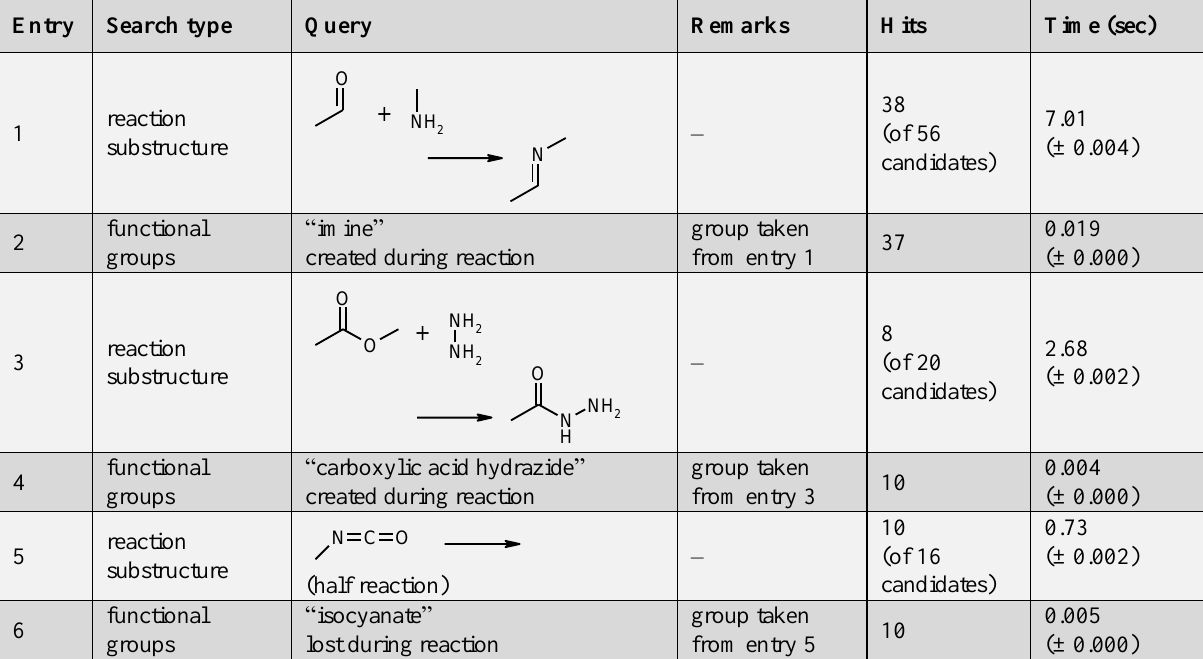
Table 2. Comparison of performance between different search types in a database containing 500